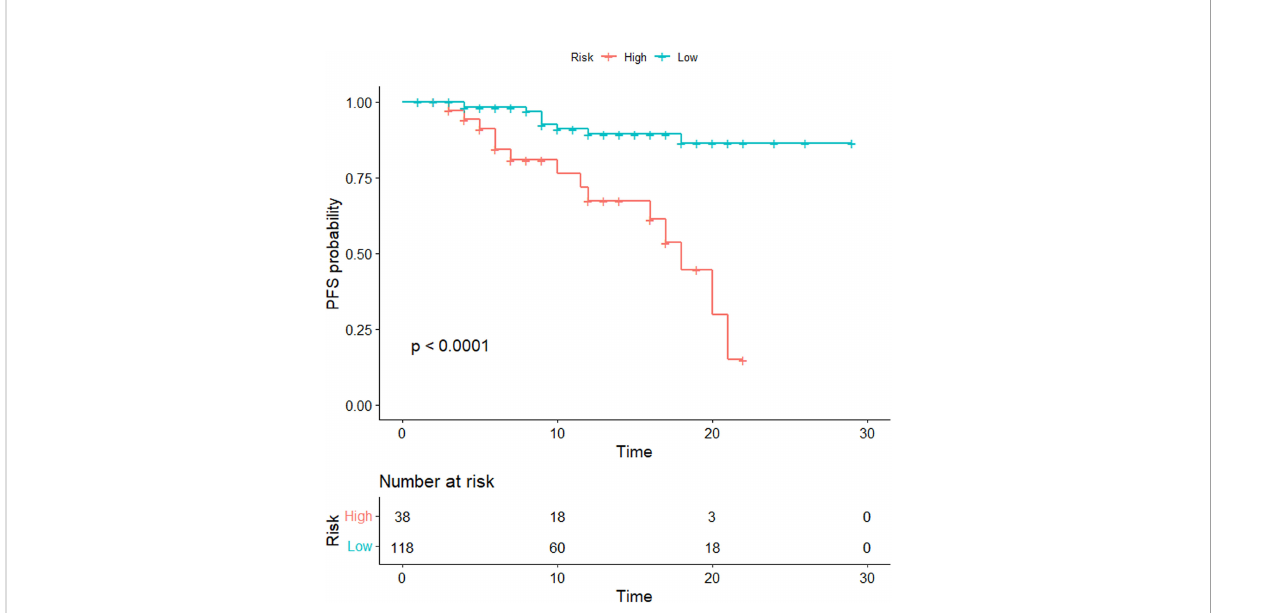
FIGURE 6 Kaplan – Meier analyses were performed to estimate progression-free survival in clinical subgroups. The patients were divided into high- and low-risk groups according to the threshold value of 3.1. Kaplan – Meier analysis showed a much lower PFS in the high-risk group than that in the low-risk group ( p <